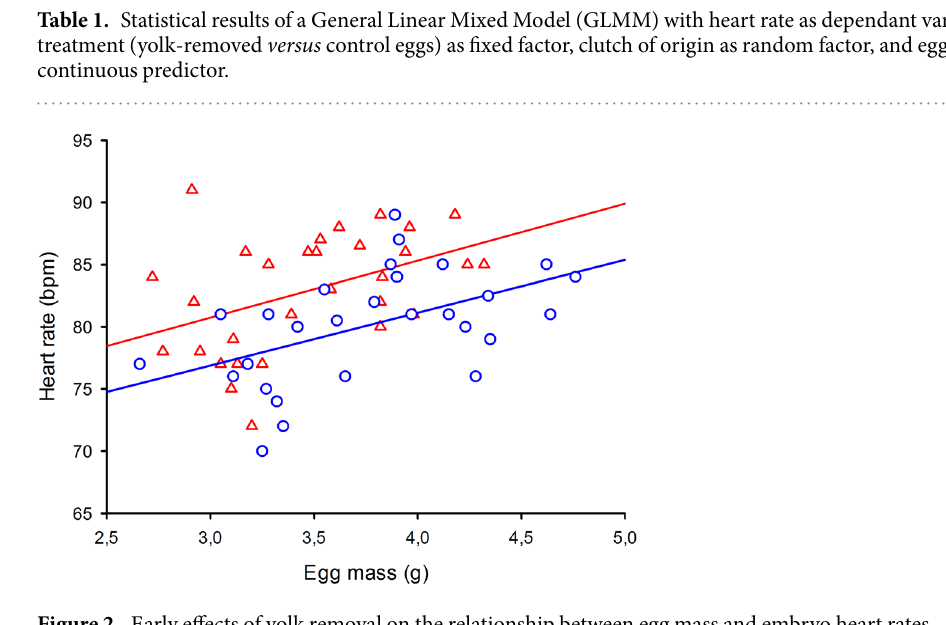
Figure 2. Early effects of yolk removal on the relationship between egg mass and embryo heart rates (incubation day 10) in yolk-removed (red triangles) and control water snake eggs. Heart rate and egg mass were strongly correlated in both treatments (see text for statistical details). While heart rate increased in response to yolk removal, the relationship between heart rate and egg mass was essentially unchanged. Means ± SE are plotted.